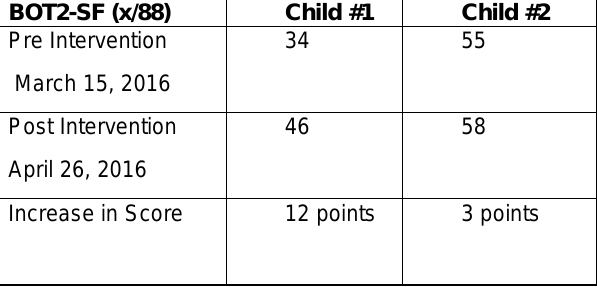
Table 2. Bruininks-Oseretsky Test of Motor